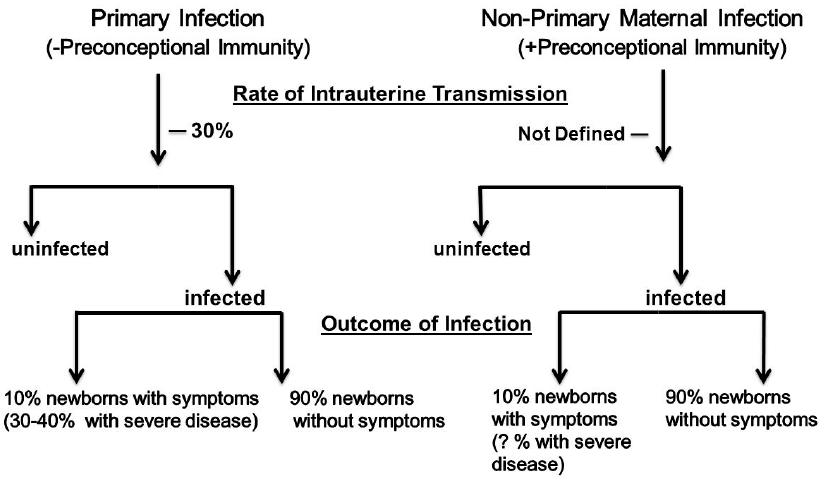
Figure 1. Congenital human cytomegalovirus (HCMV) infection during pregnancy: Classification of maternal infection and newborn outcome.